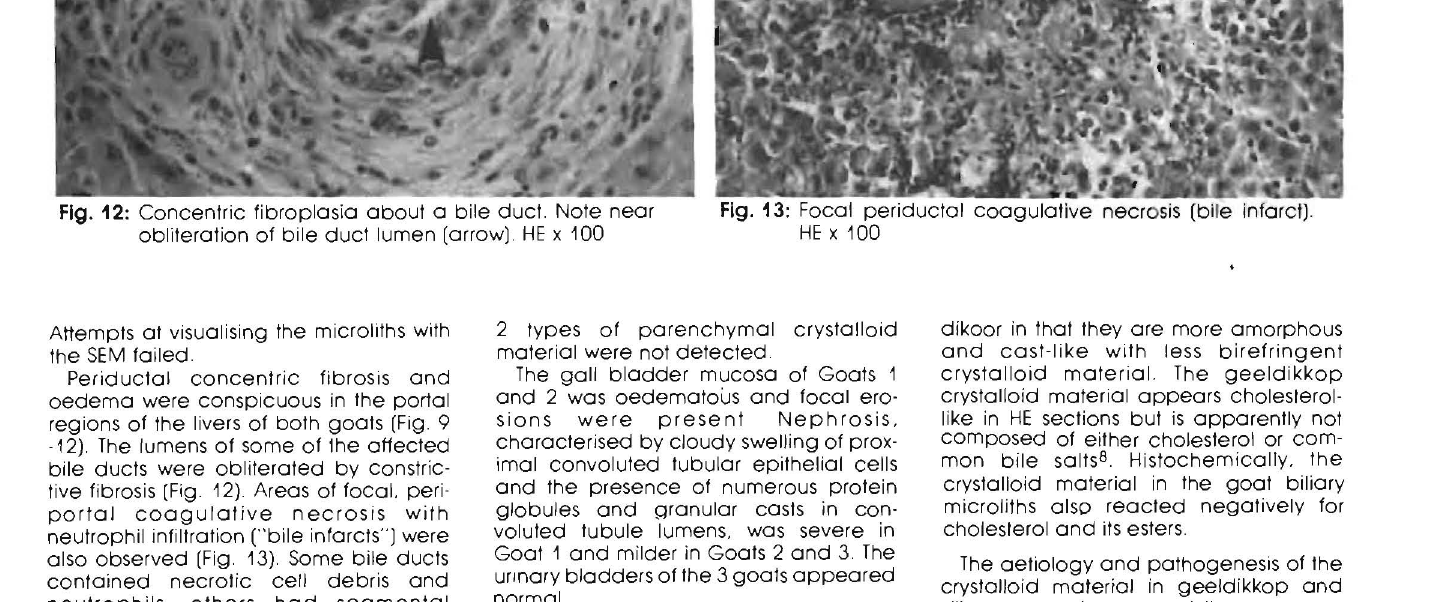
Fig. 12: Concentric fibroplasia about a bile duct. Note near obliteration of bile duct lumen (arrow). HE x 100